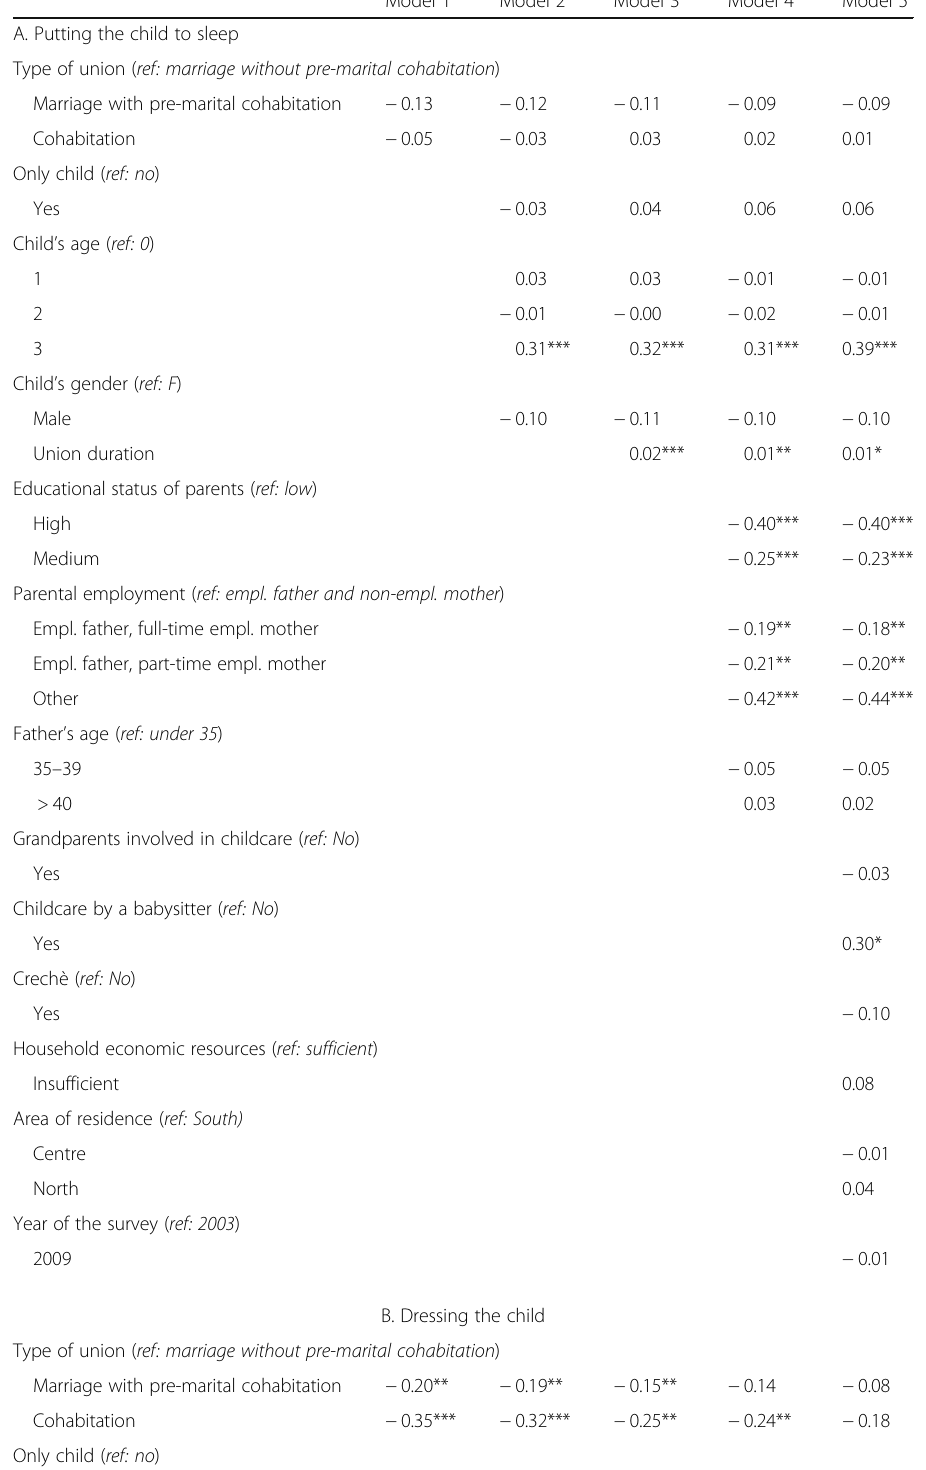
Table 3 Ordinal logistic models for fathers ’ involvement in some childcare activities — β coefficients (coefficients predicting lower involvement of fathers — 3093